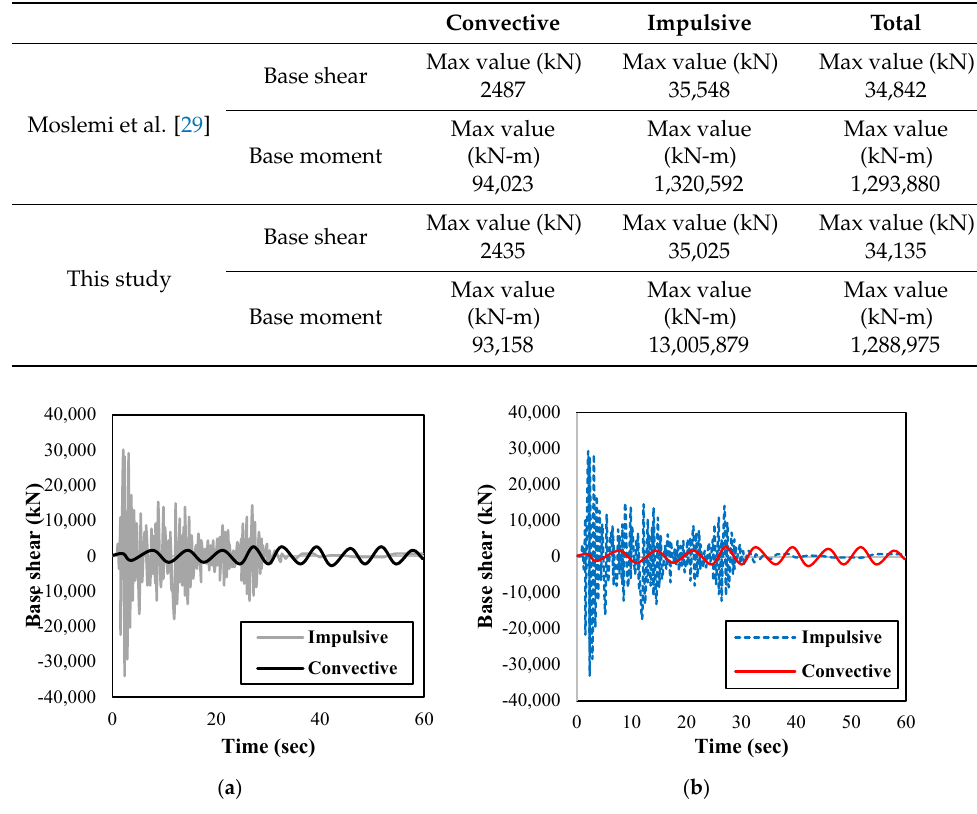
Figure 7. Time history results for the tank: ( a ) Moslemi et al. [29] and ( b ) this study.